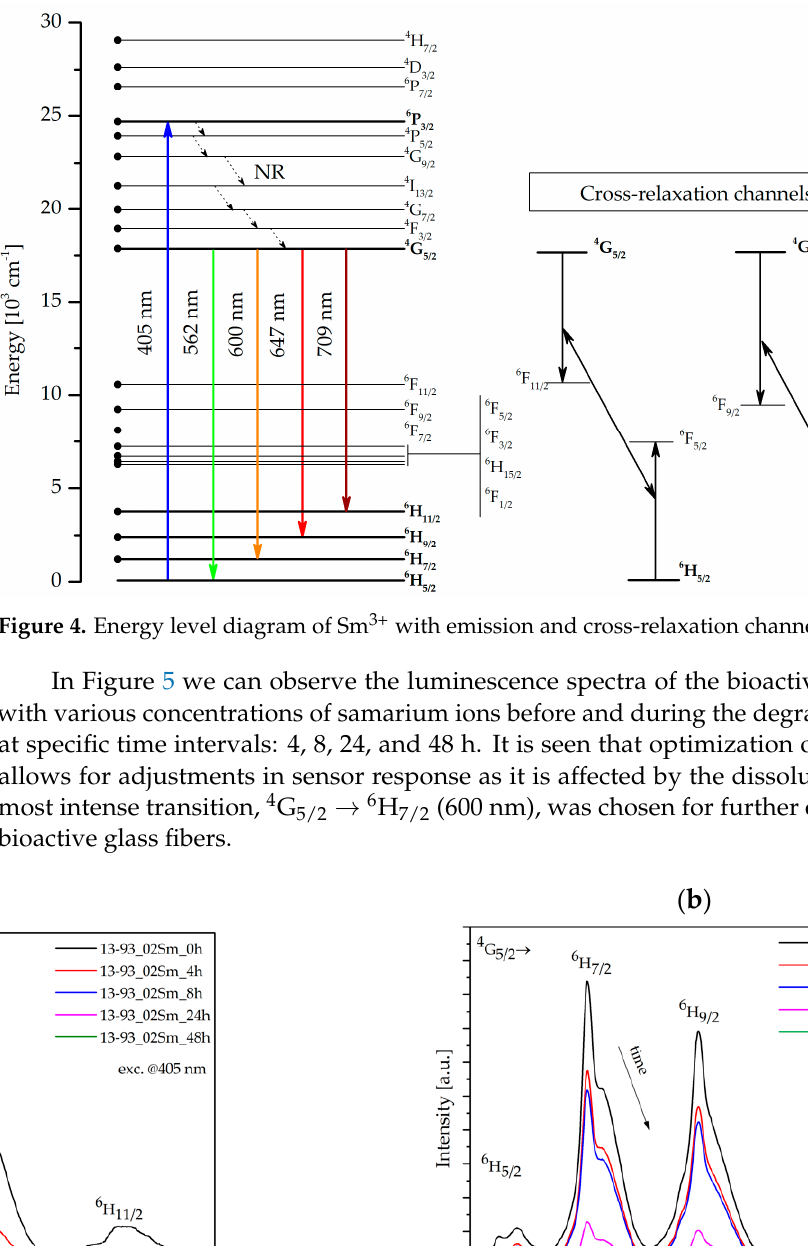
Figure 3. Luminescence spectra of 13 ‐ 93 bioactive glass doped with 0.2 and 2 %mol Sm 3+ , λ exc = 405 nm.